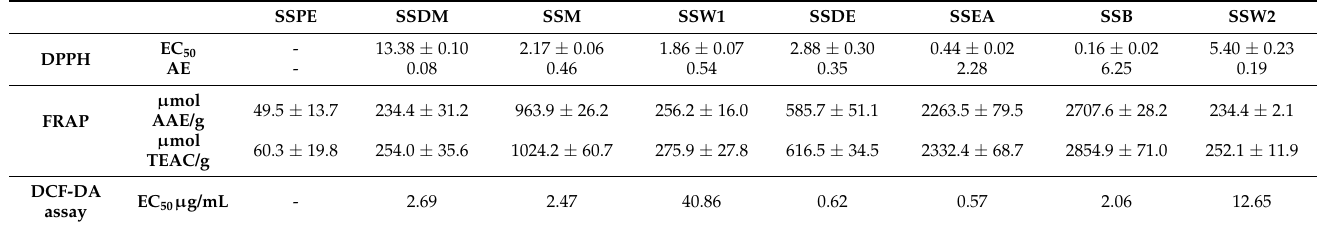
Table 3. Antioxidant capacity levels of the different mixtures derived from SS aerial parts, as estimated by DPPH · , FRAP, and DCF-DA assays. Results are shown as average values ± standard deviations. EC 50 in DPPH corresponds to the concentration of antioxidants necessary to decrease the initial DPPH by half and is measured in mg antioxidant/mg DPPH. EC 50 in DCF-DA corresponds to the concentration of fraction required to decrease by 50% the presence of radical oxygen species, induced by 50 µ M of H 2 O 2